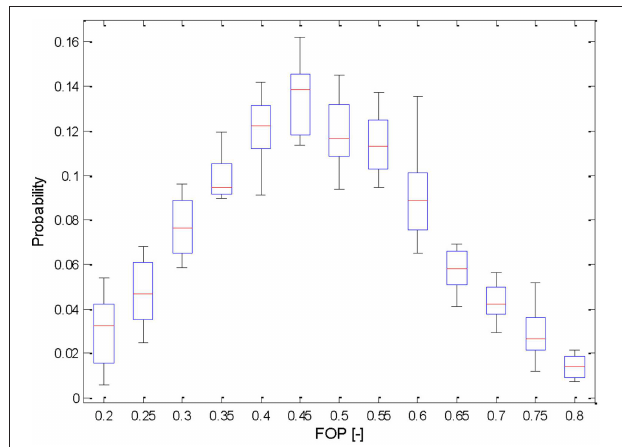
FIGURE 11 | Fraction of presence boxplot. Reproduced from Mahdavi and Tahmasebi (2015) with permission from A. Mahdavi, and F.